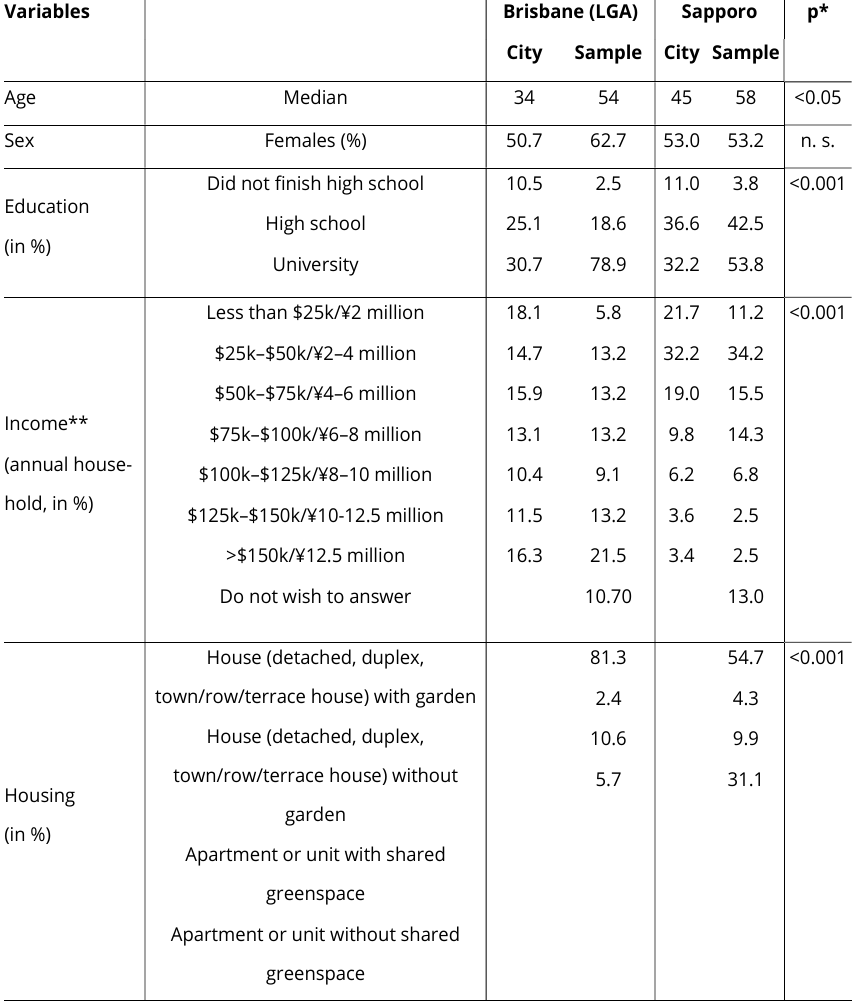
Table 2. Sample population characteristics and comparison with census data (adopted from Rupprecht et al.